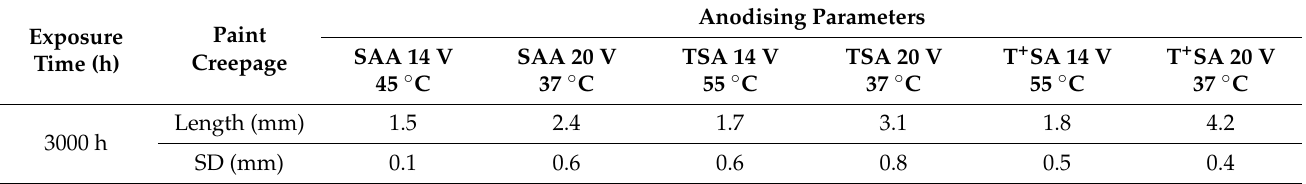
Table 3. Average length of maximum paint creepage of triplicate test and standard deviation after 3000 h exposure to the neutral salt spray